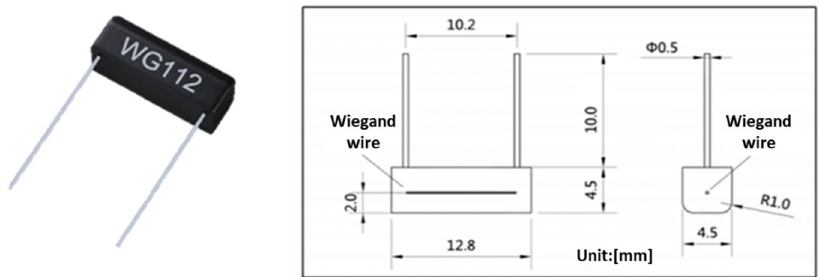
Figure 4. Dimensions of the commercial WG112 Wiegand sensor used in this research.